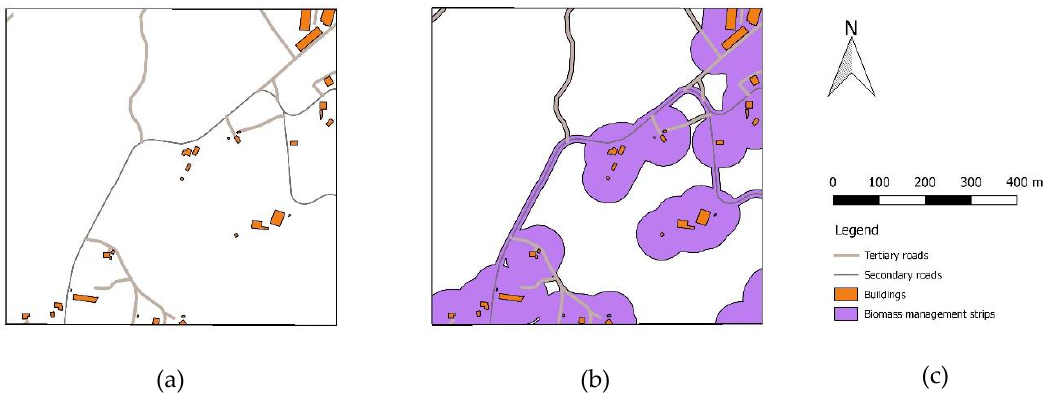
Figure 5. Process of creating the biomass management strips: ( a ) infrastructure layers in Dataset 1 (buildings, tertiary and secondary roads); ( b ) biomass management strips (purple polygons), created by means of infrastructure layers; and ( c ) legend and graphic scale.